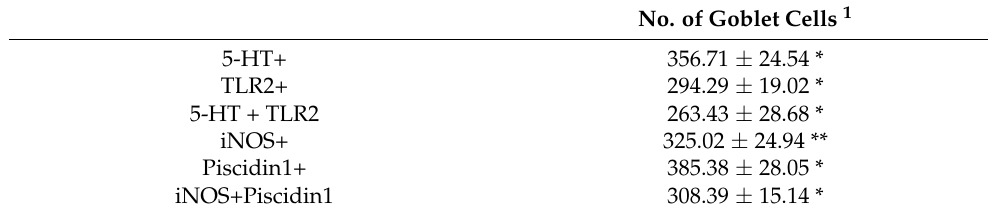
Table 2. Quantitative analysis data (mean values ± standard deviation; n =